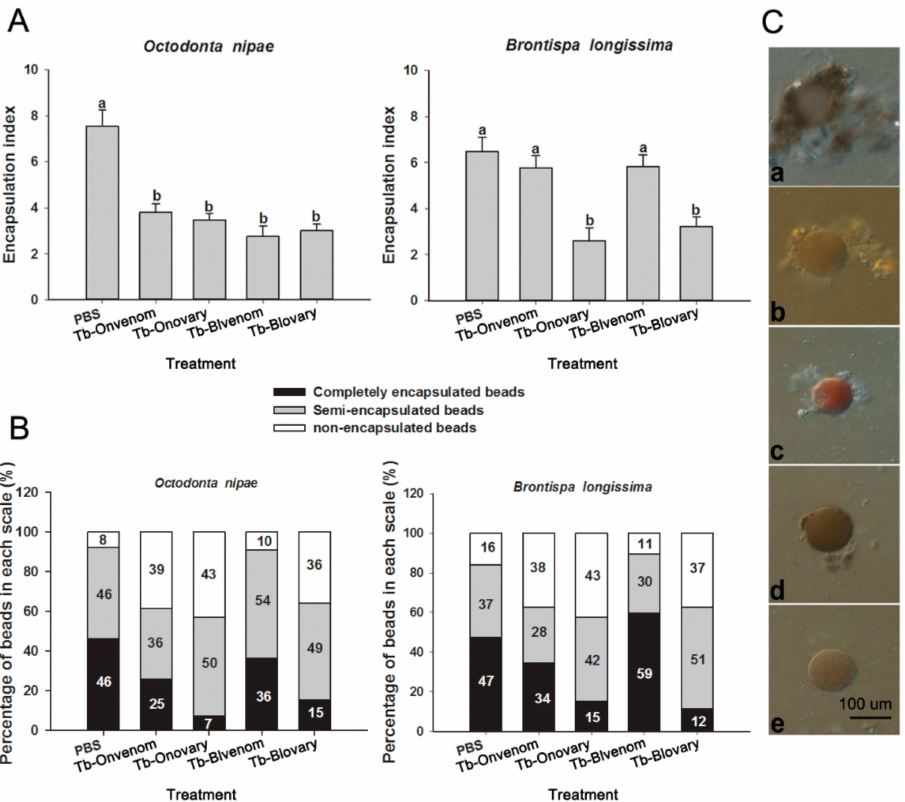
Figure 4. Effect of various virulent factors on haemocyte encapsulation. ( A ) Encapsulation index of O. nipae and B. longissima haemocytes at 24 h after treatments. ( B ) Number of beads of each scale in various treatments. The encapsulated beads were separated into three scales, depending on the number of haemocytes attached to the beads. ( C ) Beads with varying degrees of encapsulation. Different letters correspond to significant differences at the 0.05 level between different tissues (one-way ANOVA followed by Dunnett’s test). Scale bars, 100 µ